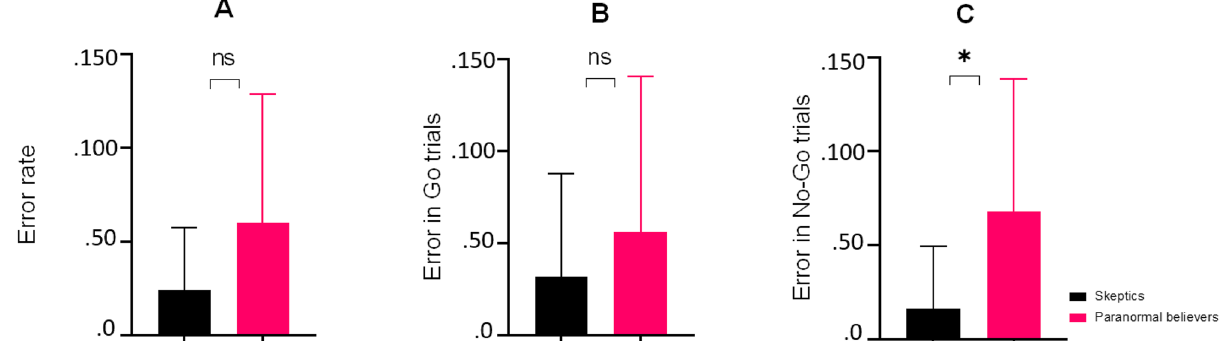
Figure 2. The behavioral performance in the paranormal believers and skeptics groups on the Go/No-Go task in ( A ) error rate, ( B ) error in Go trials, and error in No-Go trials. The error bars are SD. The black bar charts and red bar charts are for skeptics and paranormal believers groups respectively. *P <